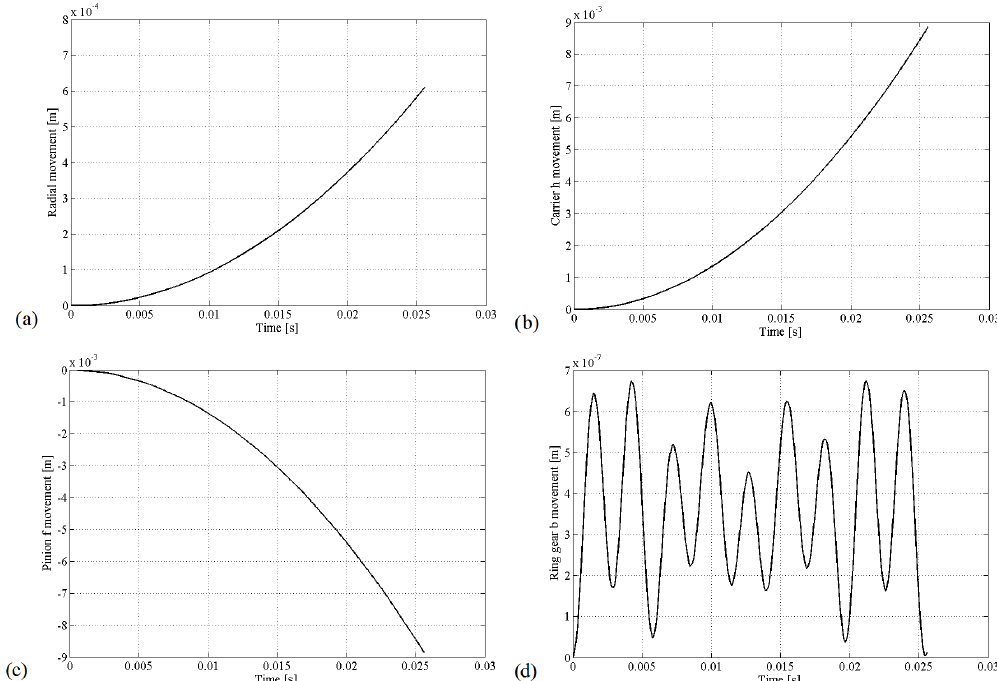
Figure 6. Displacement diagrams for c 1 = 1 . 67 × 10 10 Nm − 1 , c 2 = 1 . 56 × 10 10 Nm − 1 , k 1 = 3200Nsm − 1 , and k 2 = 2400Nsm − 1 : (a) y 1 direction, (b) θ h direction, (c) θ f direction, and (d) θ b direction.